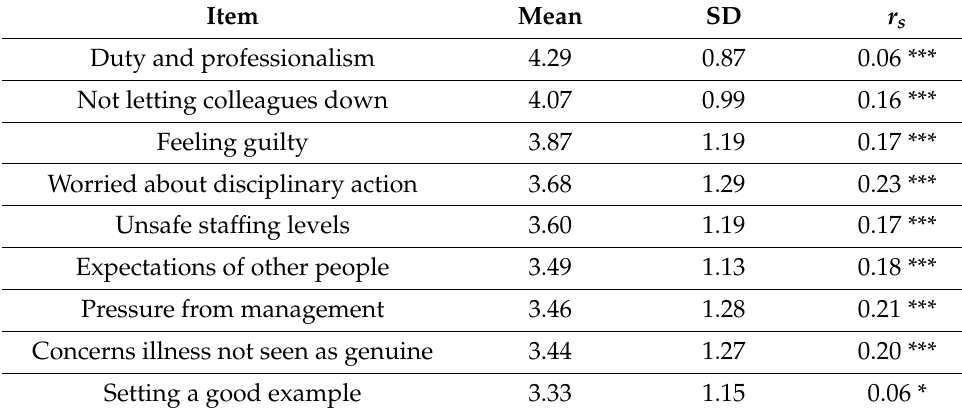
Table 1. Reasons for presenteeism in descending order (higher scores represent higher levels of endorsement) with descriptive statistics and correlation coefficients with mean presenteeism